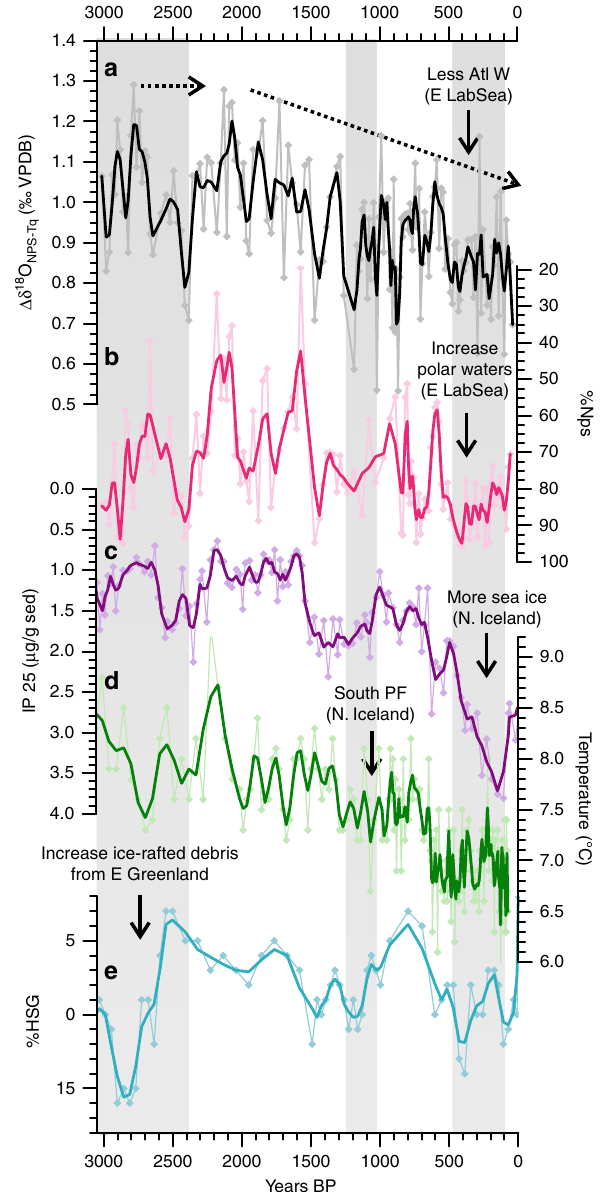
Fig. 2 Changes in the southward in fl uence of polar waters. a Difference in the δ 18 O measurements of N . pachyderma (s) and T . quinqueloba from RAPiD-35-COM as an indicator of the relative presence of Atlantic waters in the Eastern Labrador Sea (data between 0 and 1250 years BP presented in ref. 13 ). b Percentage of the polar species N . pachyderma (s) from RAPiD- 35-COM (data between 0 and 1250 years BP presented in ref. 13 ). c Sea ice reconstructions based on IP25 proxy from core MD99-2269 28 located North of Iceland (Fig. 1). d Diatom assemblage derived August temperatures from North of Iceland 27 . e Percentage of haematite stained quartz grains (HSG) from MC52-VM29-191 11 . Bold lines indicate